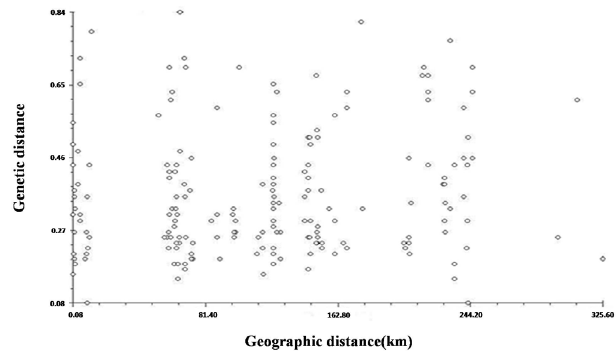
Fig 3 . Correlation between genetic and geographical distance. The data points were generated by MXCOMP programs and shown as a scattered pattern. No significant correlation were identified between genetic and sample geographical distance by Mantel test ( r = 0.10517, p =